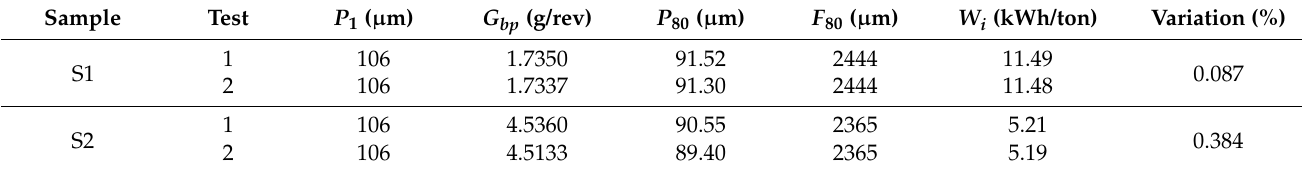
Table 4. Test repeatability of the Bond work index for untreated samples S1 and